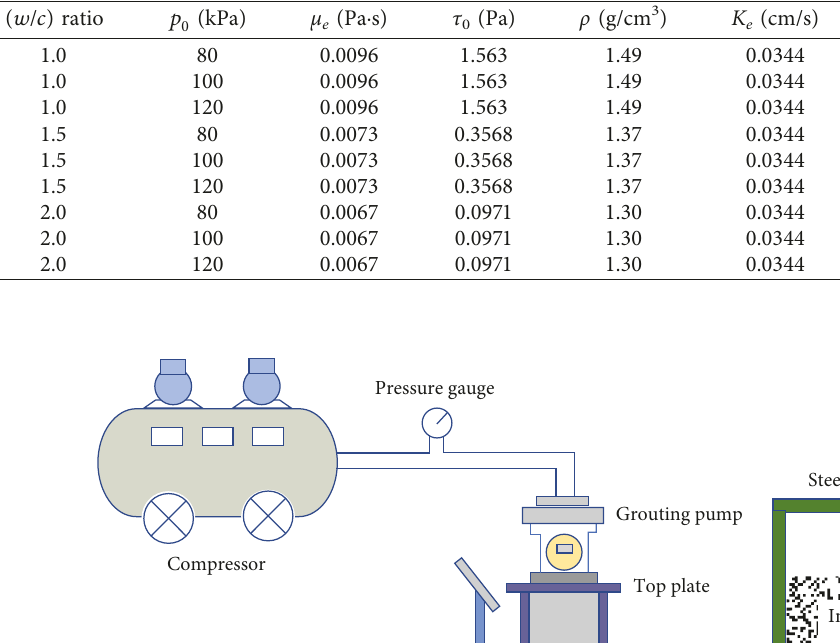
Table 3: Material property of the used cement grouts.